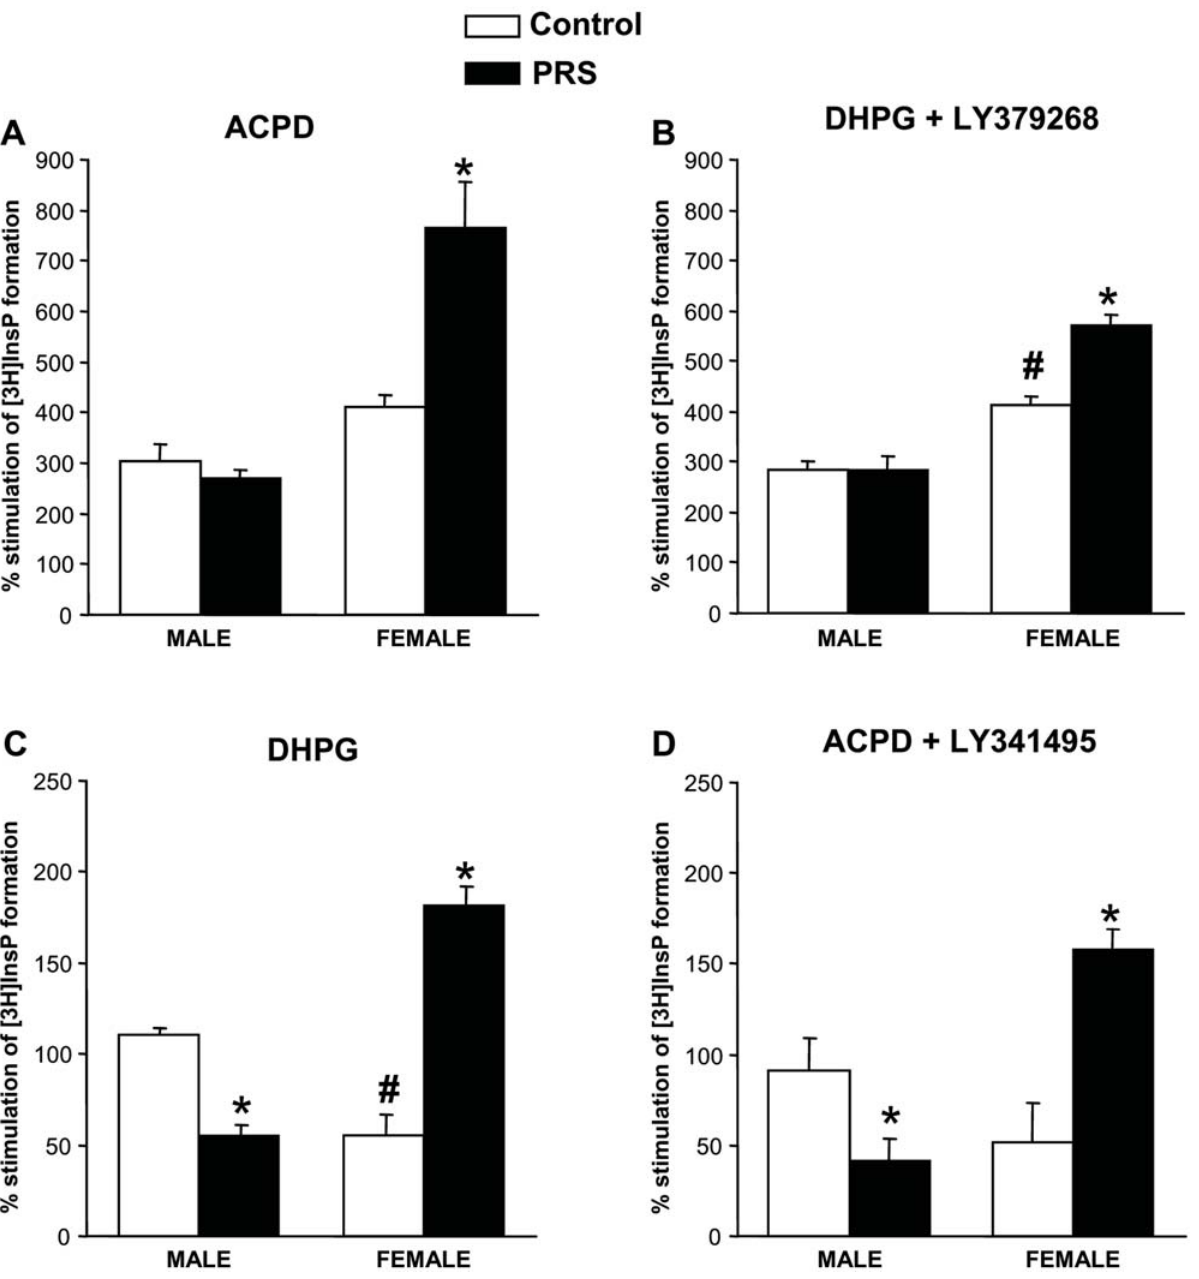
Figure 6. Gender effect in the effect of PRS on mGlu receptor-mediated PI hydrolysis in hippocampal slices. Stimulation of PI hydrolysis by the mixed mGlu receptor agonist, 1S,3R-ACPD (100 m M) (A) , the selective mGlu1/5 receptor agonist, DHPG (200 m M) (C) , DHPG combined with the selective mGlu2/3 receptor agonist, LY379268 (1 m M) (B) , or 1S,3R-ACPD combined with the preferential mGlu2/3 receptor antagonist, LY341495 (1 m M) (D) in slices prepared from the whole hippocampus of male and female control and PRS rats. Values are expressed as means 6 S.E.M. of 9 individual measurements from 3 independent experiments. ANOVA for group 6 sex: F (1,12) =14.23, p , 0.05 for ACPD; F (1,12) =14.30, p , 0.05 for DHPG + LY379268; F (1,12) =97.12, p , 0.05 for DHPG; F (1,12) =23.01, p , 0.05 for ACPD + LY341495. * p , 0.05 Newman-Keul’s post-hoc test for PRS vs. control animals; # p , 0.5 female vs. male rats.